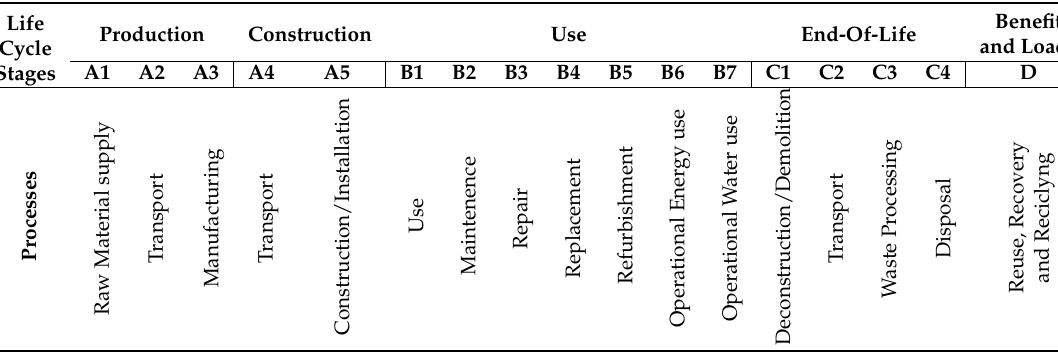
Table 1. Life cycle stages according the EN 15978:2011